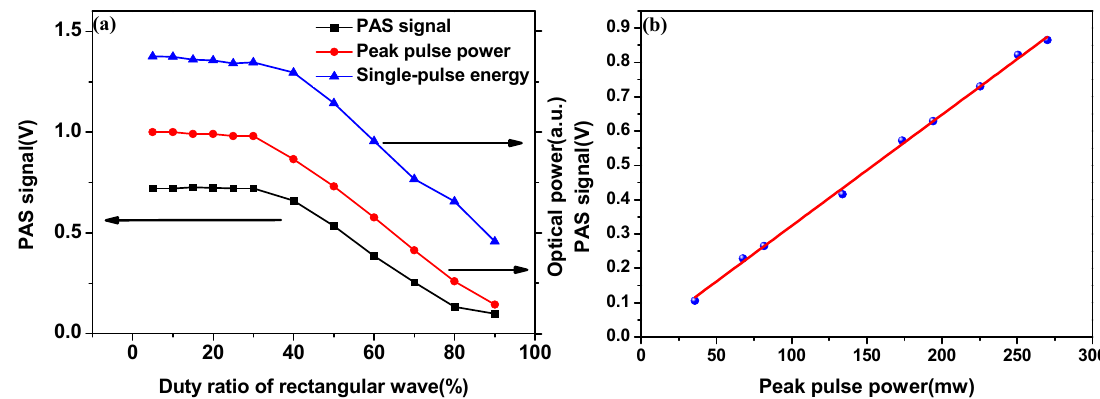
Figure 3. ( a ) Measured PAS signal, peak pulse power, and single-pulse energy at different duty ratio of modulation signal; ( b ) Response of PAS signal to peak pulse power in the case of a constant average power.